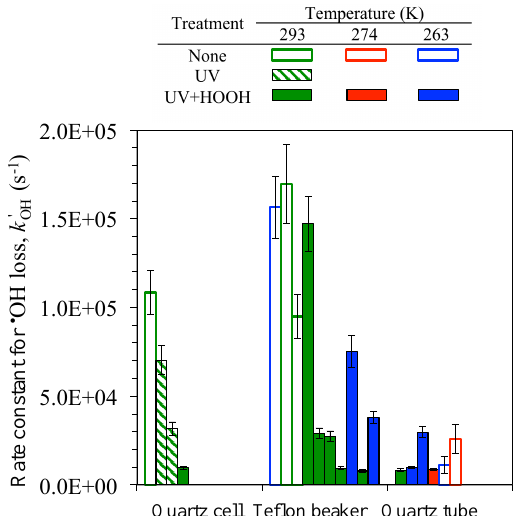
Figure 1. Effects of container type and cleaning on the apparent rate constant for • OH destruction in Milli-Q blanks. Open bars rep- resent containers with no extra treatment, hatched bars have UV treatment (container with Milli-Q illuminated for ≥ 8h with 254nm radiation), and solid bars are containers treated with 100µM added HOOH followed by ≥ 8h of UV treatment. Bars within a given treatment are listed in chronological order, from the initial to the final experiment. Error bars represent ± 1 standard error, based on propagated errors of the linear regression of 1 /p -HBA vs. 1 / [ BA ] and the second-order rate constant for • OH with BA.